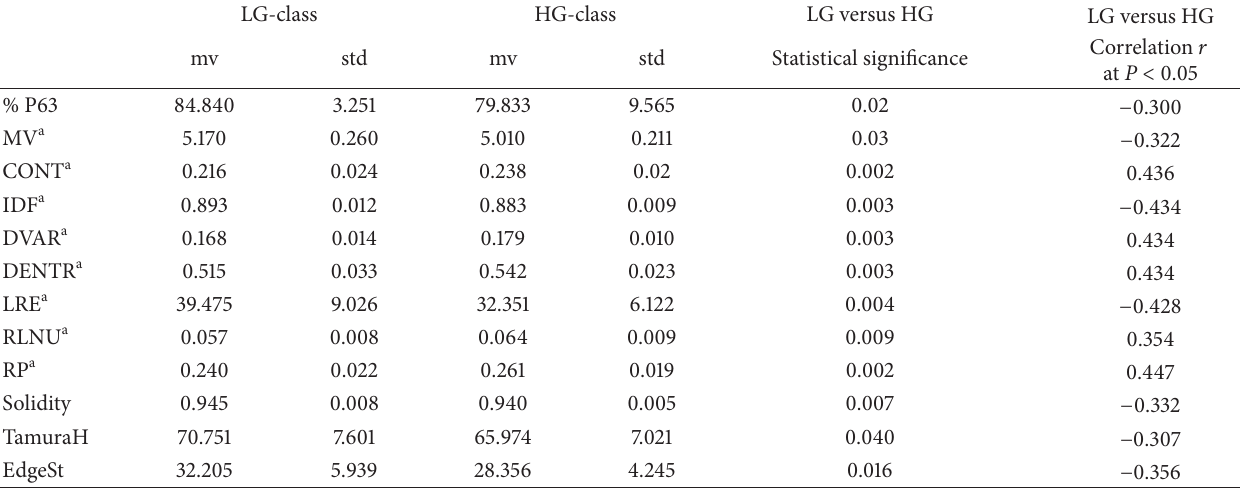
Table 2: Means, standard deviations, statistical significance, and correlations of features with statistically significant differences between High Grade and Low Grade laryngeal tumor